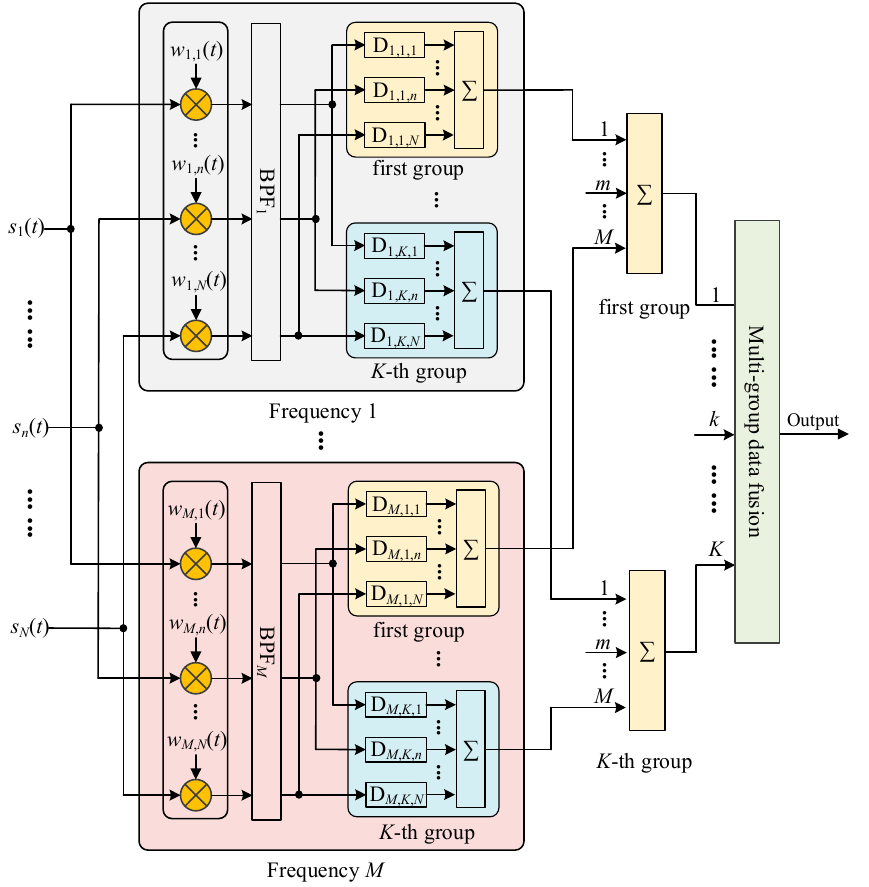
Figure 10. Processing diagram of the proposed DBF processor with multi-frequency and multi-group time delays.